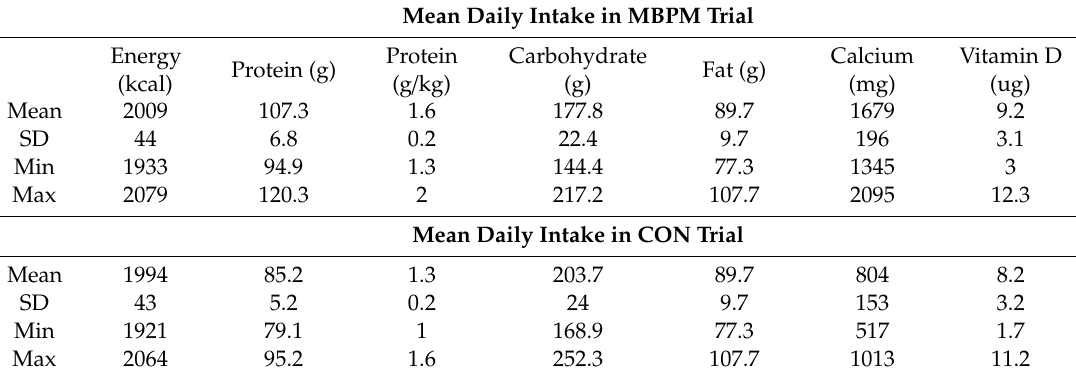
Table 2. Mean daily nutrient intake for the calcium-fortified, milk-derived protein matrix (MBPM) and maltodextrin (CON) trials ( n =